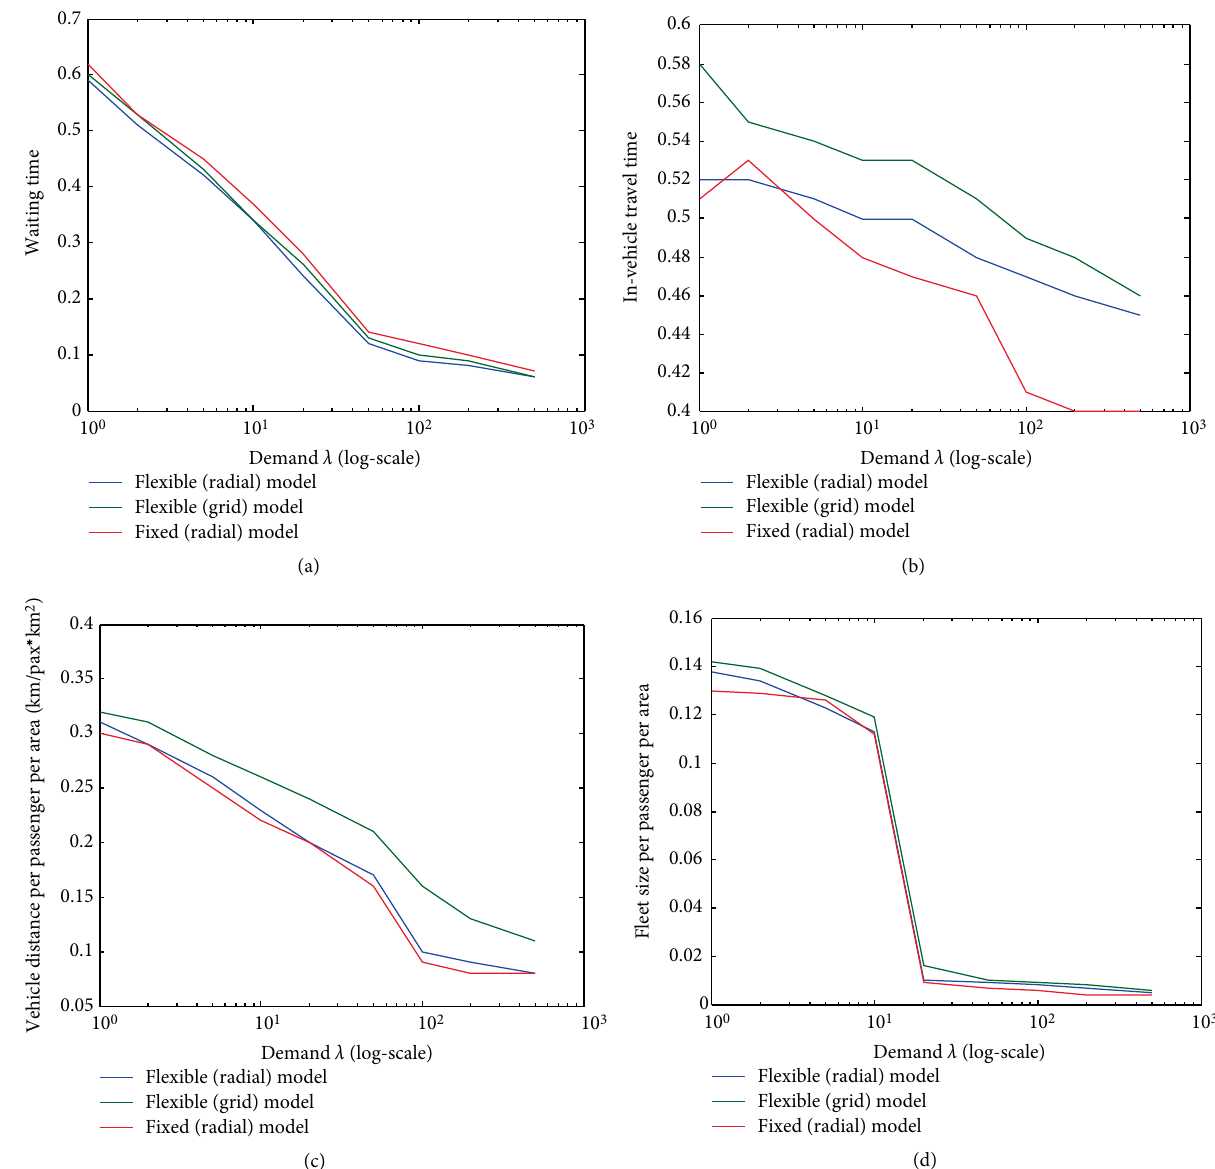
Figure 7: Different cost components of three transit systems. (a) Waiting time versus demand levels. (b) In-vehicle travel time versus demand levels. (c) Vehicle distance versus demand levels. (d) Fleet size versus demand